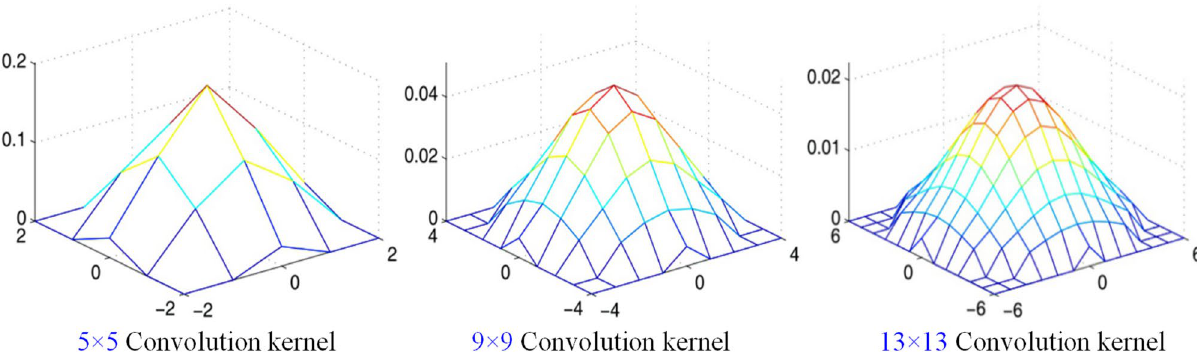
Figure 4. Two-dimensional Gaussian distribution function.